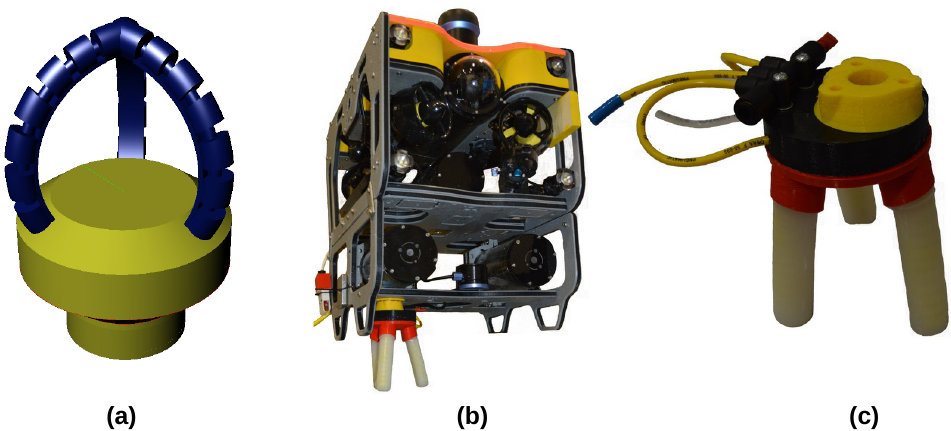
Figure 8. Soft gripper ( a ) design considering the maximum displacement of soft actuators, ( b ) in- stalled in the ROV, and ( c ) showing the details of the